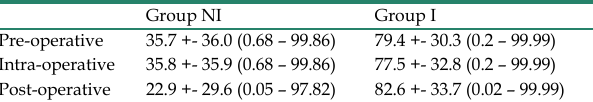
Table 4. Mean +- SD and minimum and maximum chance (%) of having a peri-prosthetic joint infection, calculated with the CDT App on the basis of pre-, intra- and post-operative findings. Group NI: patients treated as not infected; Group I: patients treated as